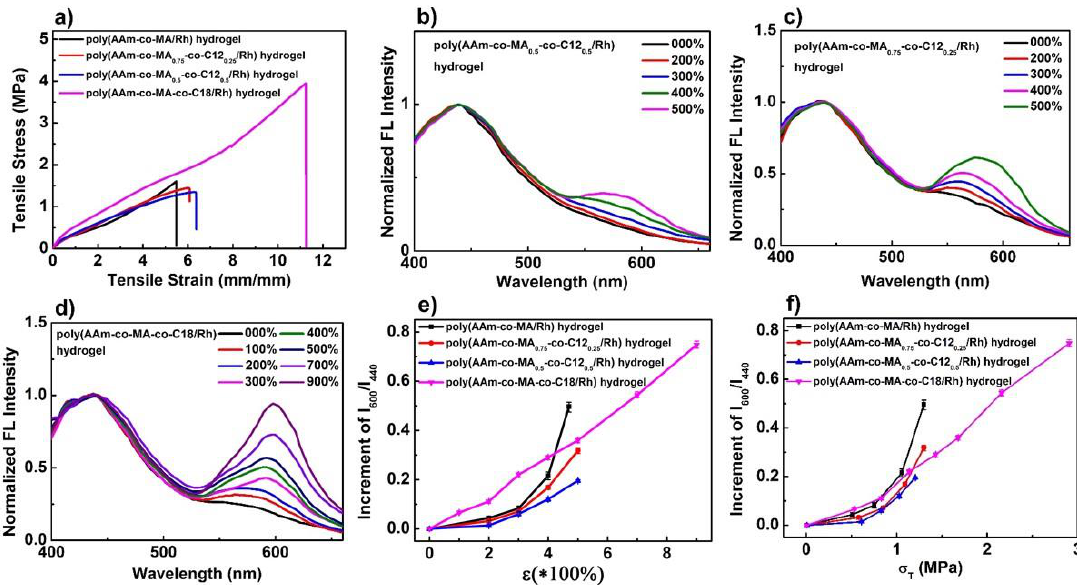
Figure 7. ( a ) The tensile stress–strain curves of poly(AAm-co-MA/Rh) hydrogel (black line), poly(AAm-co-MA 0.75 -co-C12 0.25 /Rh) hydrogel (red line), poly(AAm-co-MA 0.5 -co-C12 0.5 /Rh) hydrogel (blue line), and poly(AM-co-MA-co-C18/Rh) hydrogel (purple line), with a solid content of 70 wt% and the same Rh crosslinker concentration of 0.5 mol% of MA. Emission spectra of ( b ) poly(AAm-co-MA 0.5 -co-C12 0.5 /Rh), ( c ) poly(AAm-co-MA 0.75 -co-C12 0.25 /Rh), and ( d ) poly(AAm-co-MA-co-C18/Rh) hydrogels with a solid content of 70 wt% recorded at increasing strain levels during uniaxial stretching. The increment of fluorescence-intensity ratio I 600 / I 440 as a function of ( e ) stretch ratio and ( f ) stress level for the poly(AAm-co-MA/Rh) hydrogel (black line), poly(AAm-co-MA 0.75 -co-C12 0.25 /Rh) hydrogel (red line), poly(AAm-co-MA 0.5 -co-C12 0.5 /Rh) hydrogel (blue line), and poly(AM-co-MA-co-C18/Rh) hydrogel (purple line).